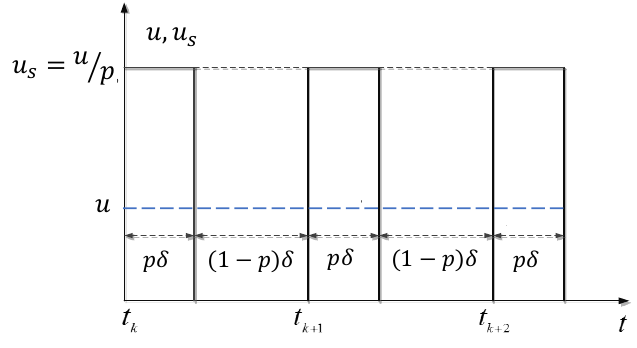
Figure 1. Signal sampled by